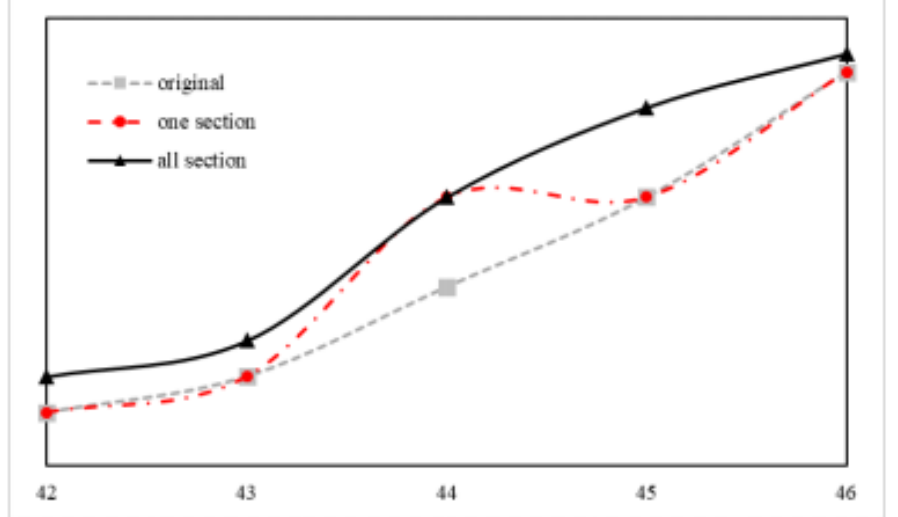
Figure 6. Demonstration of river section water level correction.